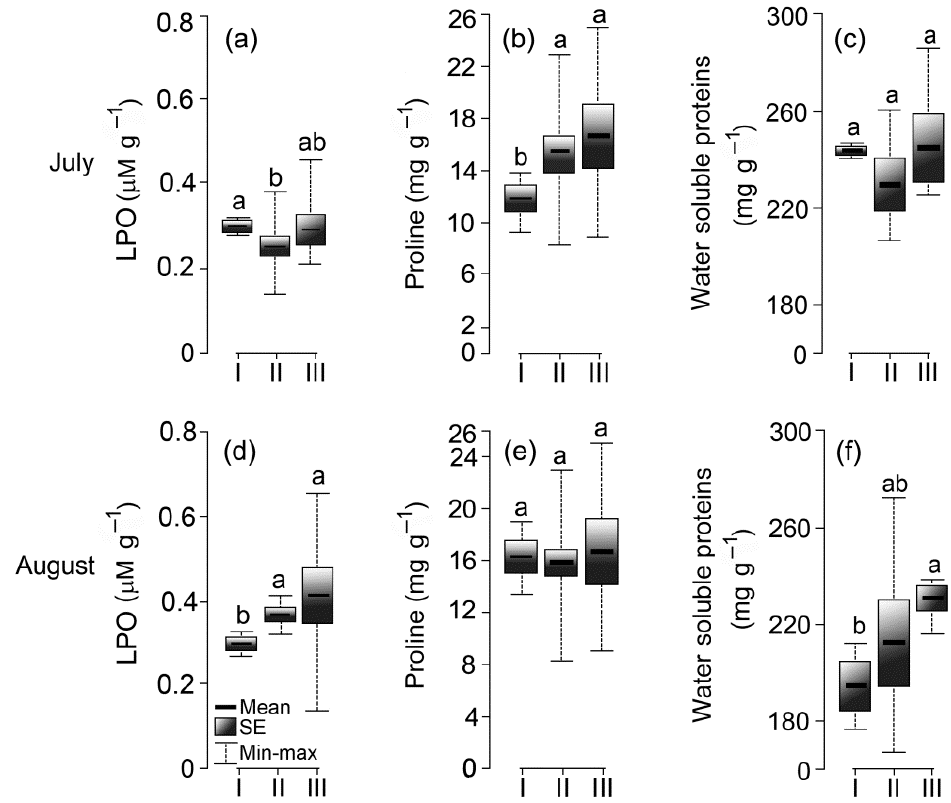
Figure 4. The content of LPO products (July—( a ), August—( d )), proline (July—( b ), August—( e )) and WP (July—( c ), August—( f )) in the leaves of potato plants depending on the ripening degree and the growing season. I—early variety; II—medium-early variety; III—mid-season.